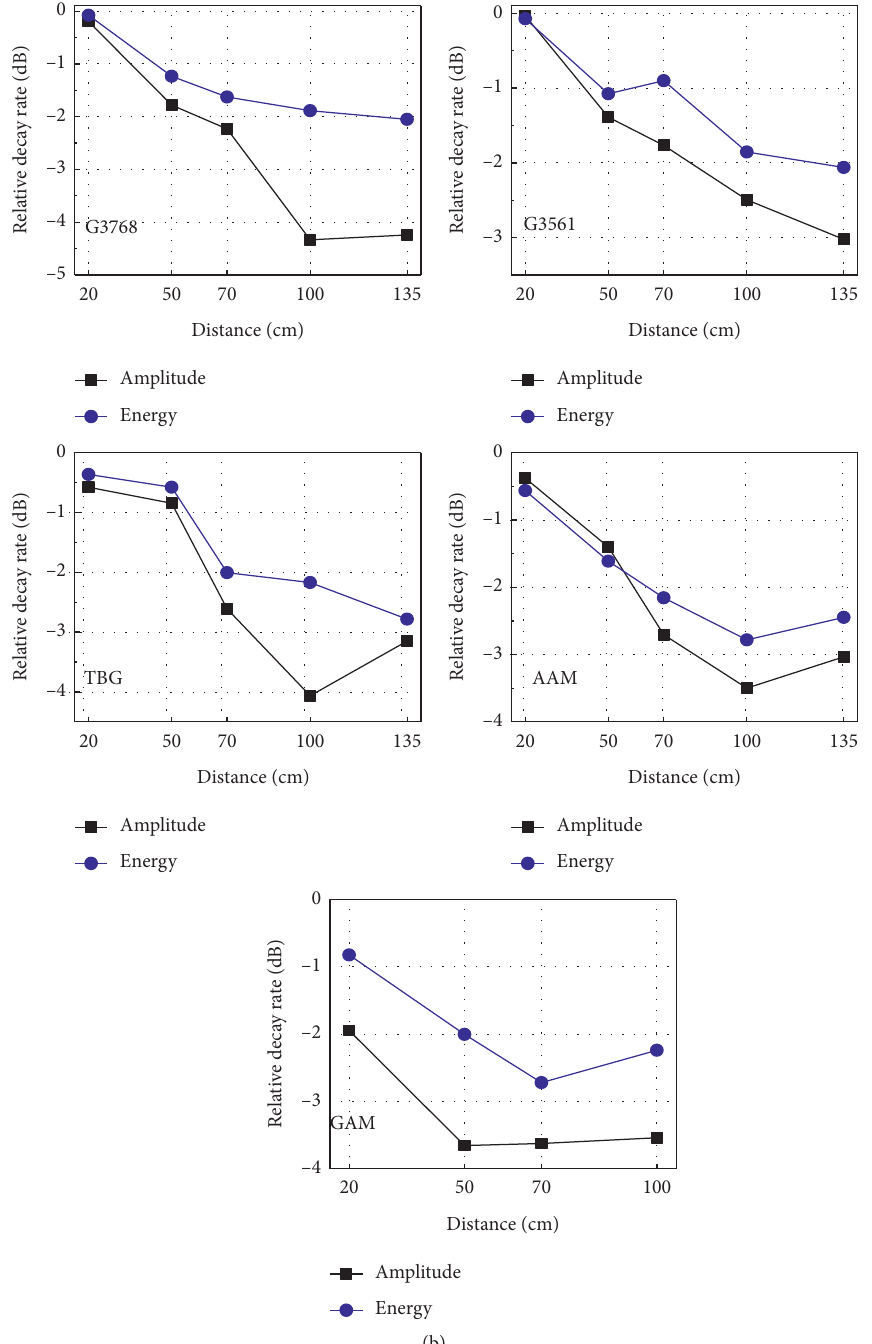
Figure 4: The attenuation rates of energy/amplitude with distance. (a) End-pulse excitation (S-wave). (b) Terminal pulse excitation (P-